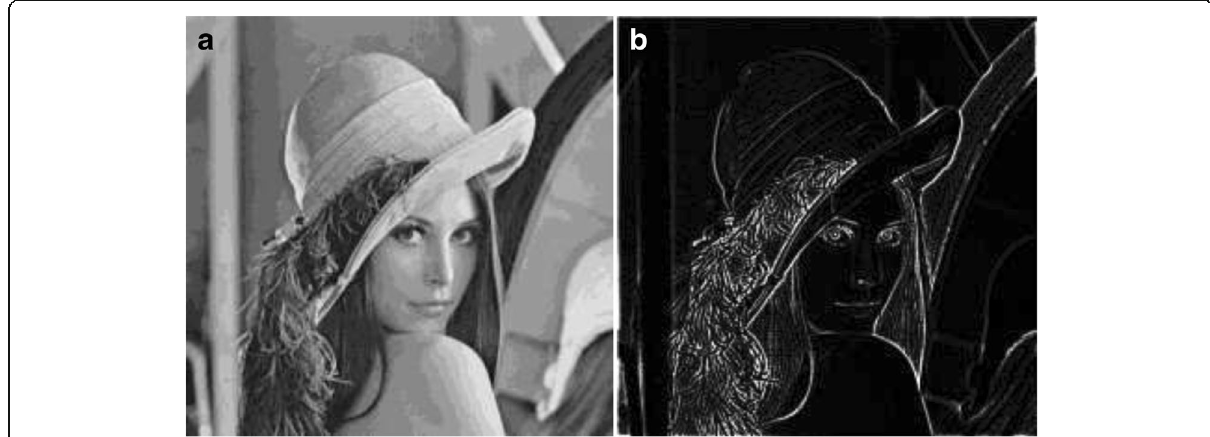
Fig. 1 Lena image and its feature map processed by PST. a Lena b PST feature of Lena